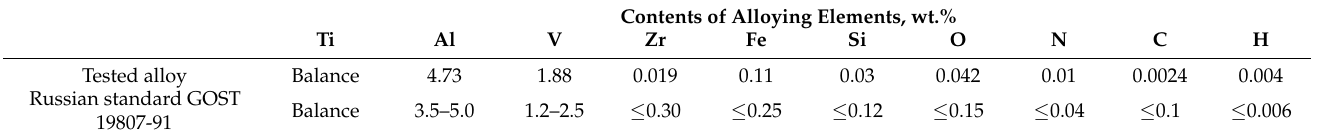
Table 1. Compositions of the titanium alloy PT-3V.